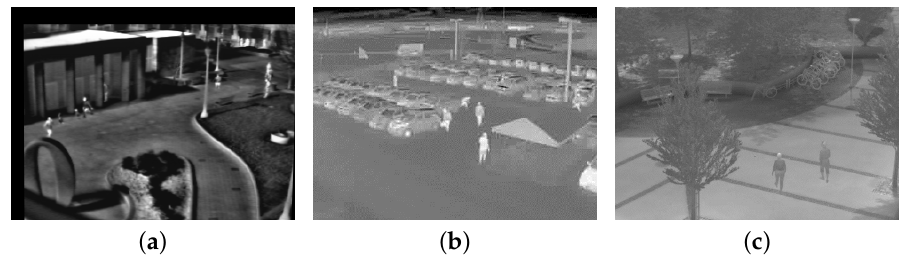
Figure 2. Three typical TIR images. ( a ) Campus; ( b ) Parking lot; ( c )